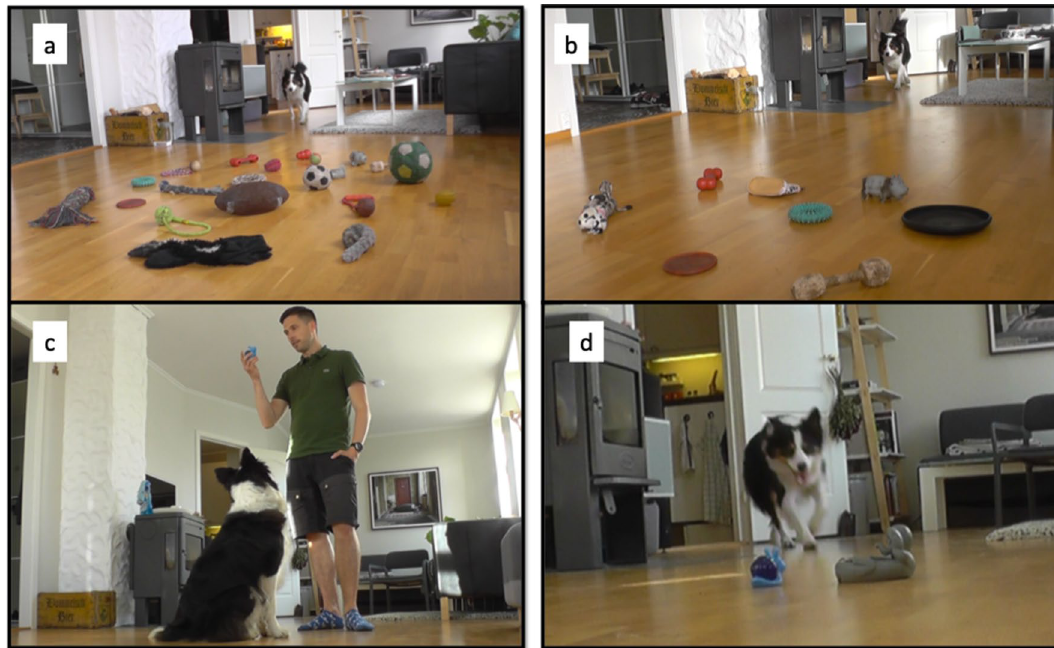
Figure 1. Scenarios of the experiment. ( a ) Baseline test : the dog is asked to select a familiar toy among other familiar toys upon hearing its name; ( b ) Exclusion condition : the dog is asked to select a new toy among familiar toys upon hearing a new word; ( c ) Social condition : the owner shows a new toy to the dog and plays with it while naming it; ( d ) Choice test : the dog is asked to select one of two toys to which it was exposed either in the exclusion condition or in the social condition